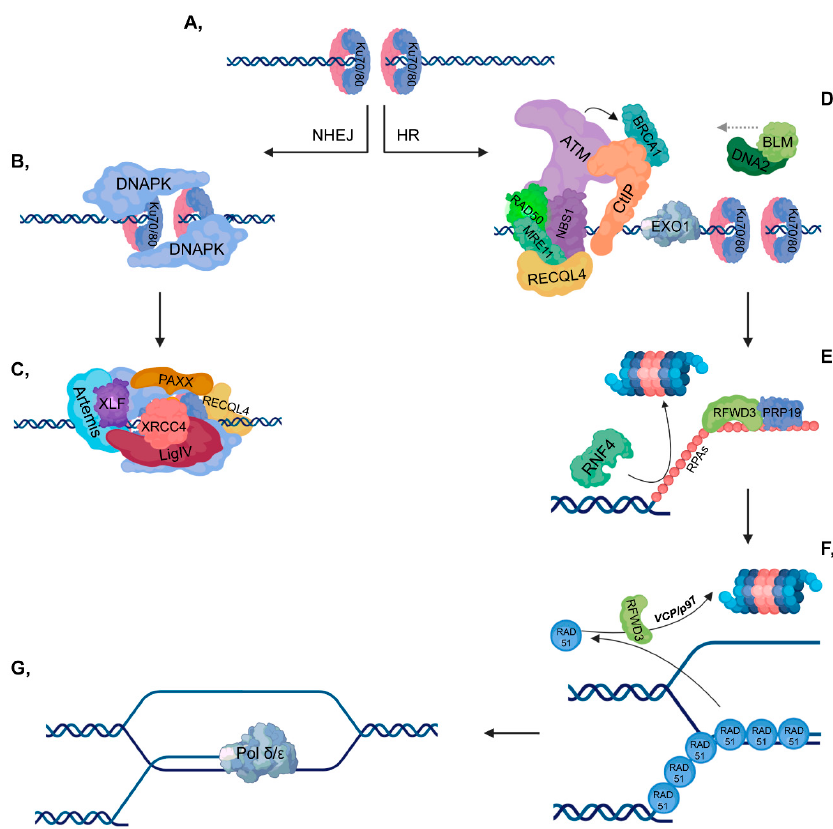
Figure 1. Double-strand break (DSB) repair pathways. ( A ) DNA double-strand break activates the binding of Ku70 / 80 heterodimers to the end of the broken DNA. ( B – C ) In non-homologous end joining (NHEJ), DNAPK is recruited to Ku70 / 80, then additional repair proteins and a ligase complex, which involves XLF-XRCC4-Ligase IV-PAXX also join. ( D – G ) In homologous recombination (HR),